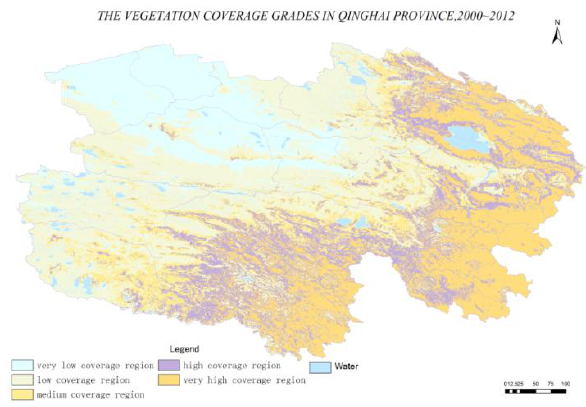
Figure 2. The average of annual maximum vegetation coverage during the period from 2000 to 2012 in Qinghai province (using different levels)